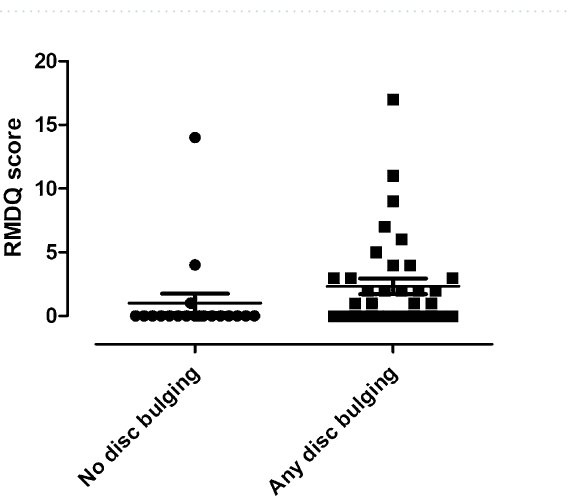
Figure 2. The relationship between the number of anterior vertebral spondylophytes and markers of OSA severity.